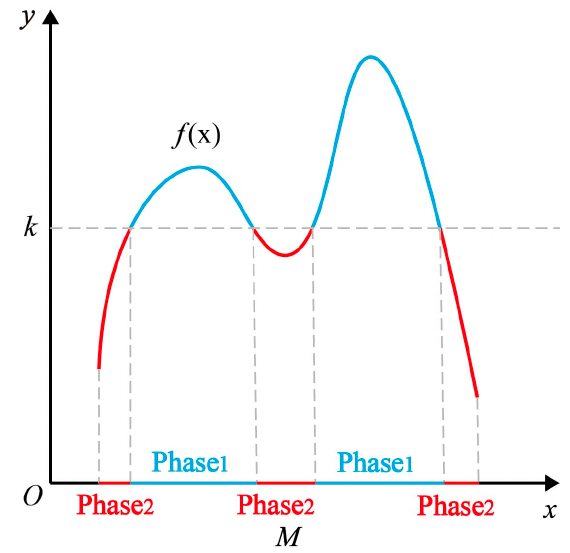
Figure 4. Binarization of a continuous field 𝑓(𝑥) .